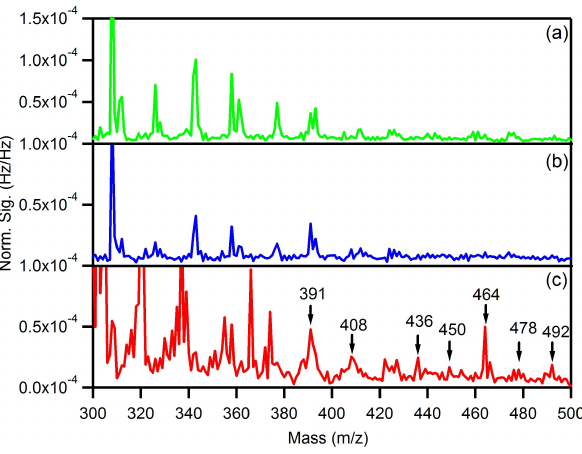
Fig. 6. Comparison of spectral scan from m/z 300–500amu for gen- erating sulfuric acid clusters using different carrier gases: (a) pure N 2 from liquid nitrogen tank; (b) zero air from pure air generator; (c) room air. For (a) and (b) , water vapor was introduced into the reactor by bubbling about 1lpm of gas through the deionized water. For (c) , water vapor was from room air and no additional water was added into the reactor. For the experimental set-up, see the text for